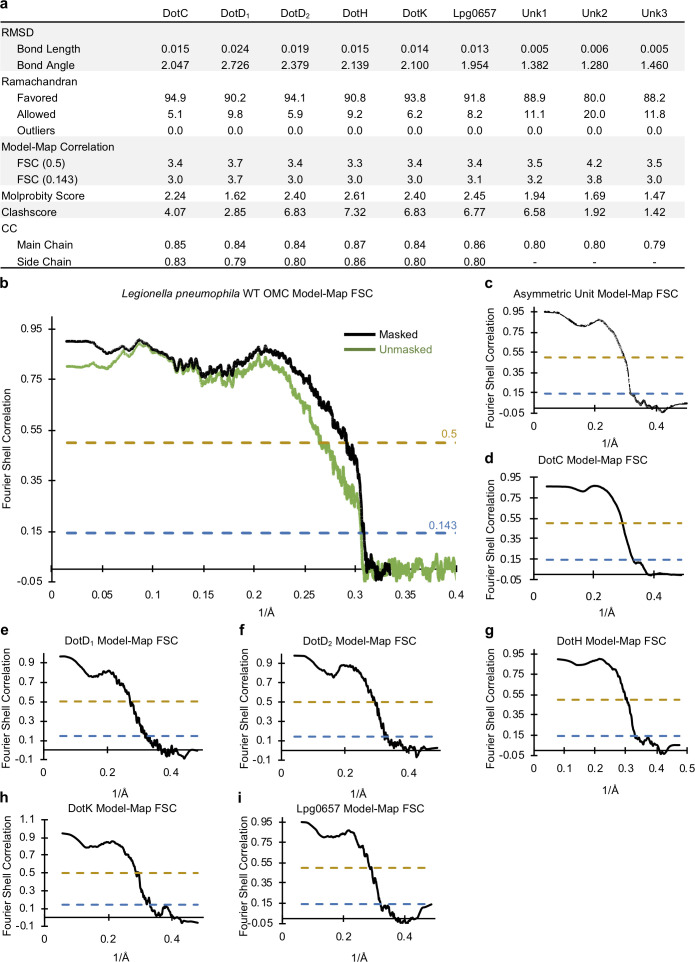
Correlation between the OMC cryo-EM map and models.(a) Statistics for each model that was constructed indicate their relative quality. (b) A model-map correlation curve for the entire OMC is shown with the unmasked data shown in green and the masked data shown in black. (c–i) The model-map correlation was also determined for each individual protein structure that was solved within the OMC.